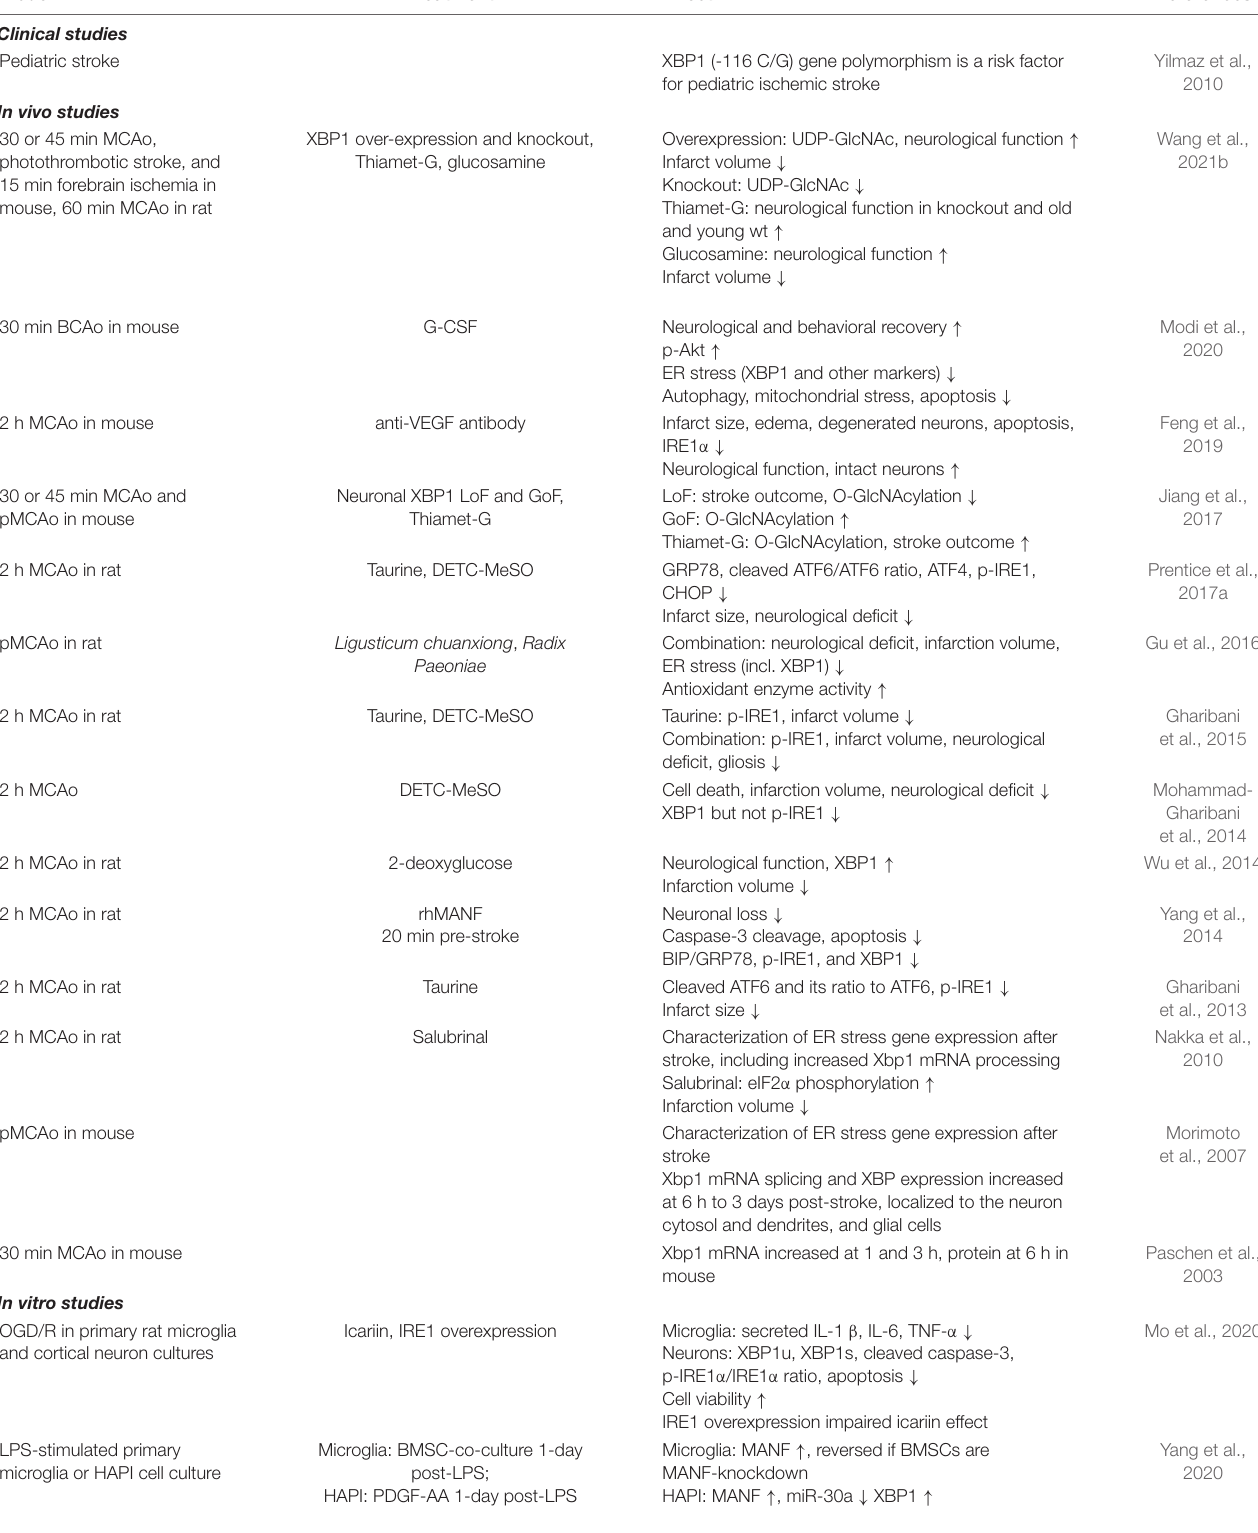
TABLE 2 | Modulation of XBP1 in